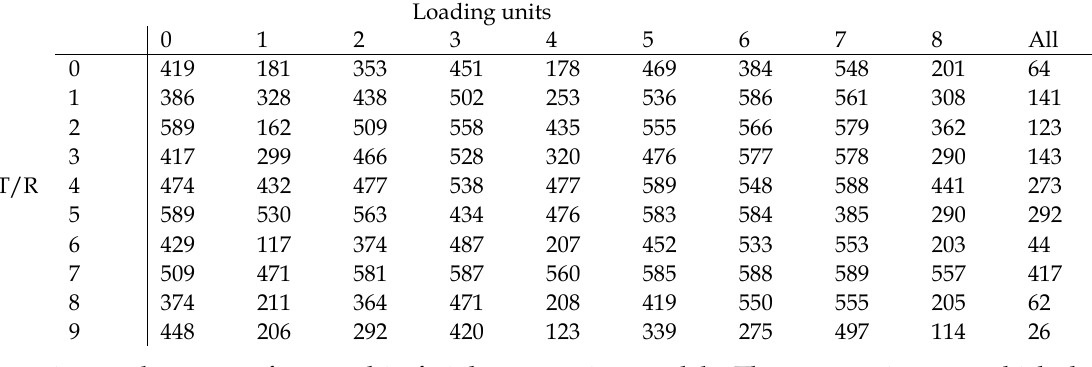
Table 3. Number of zero-observations for volume generation out of population of 589